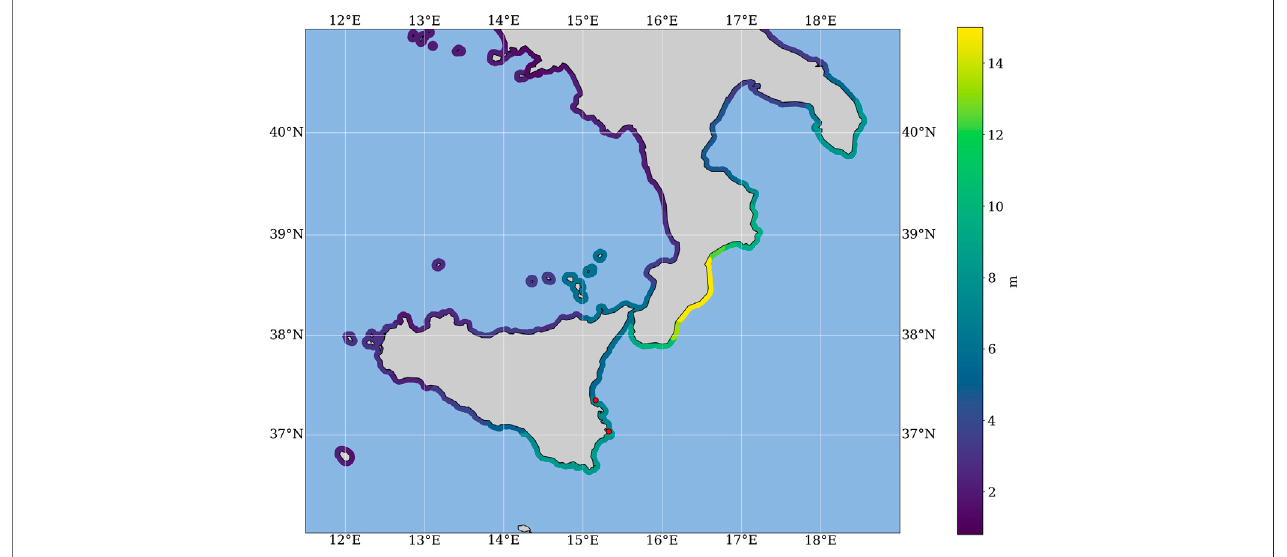
FIGURE2| Mapshowingtheresultsofthesearchingradius algorithmdescribedin DesignofItalianInundationMaps section. Each coastlinepointisassociatedto a value of R d which is used to select the discrete runup class (among 2, 5, 10, 15, 20 and 25 m) and draw the inundation line. The segments of coast in front of the two POIs in Catania and Siracusa (red dots) have R d higher than 5 m.